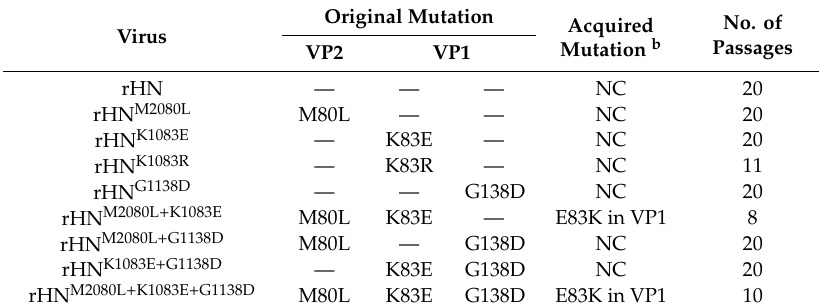
Table 3. The sequence divergence in the entire capsid-coding regions of site-directed mutants of rHN after serial passages in BHK-21 cells a